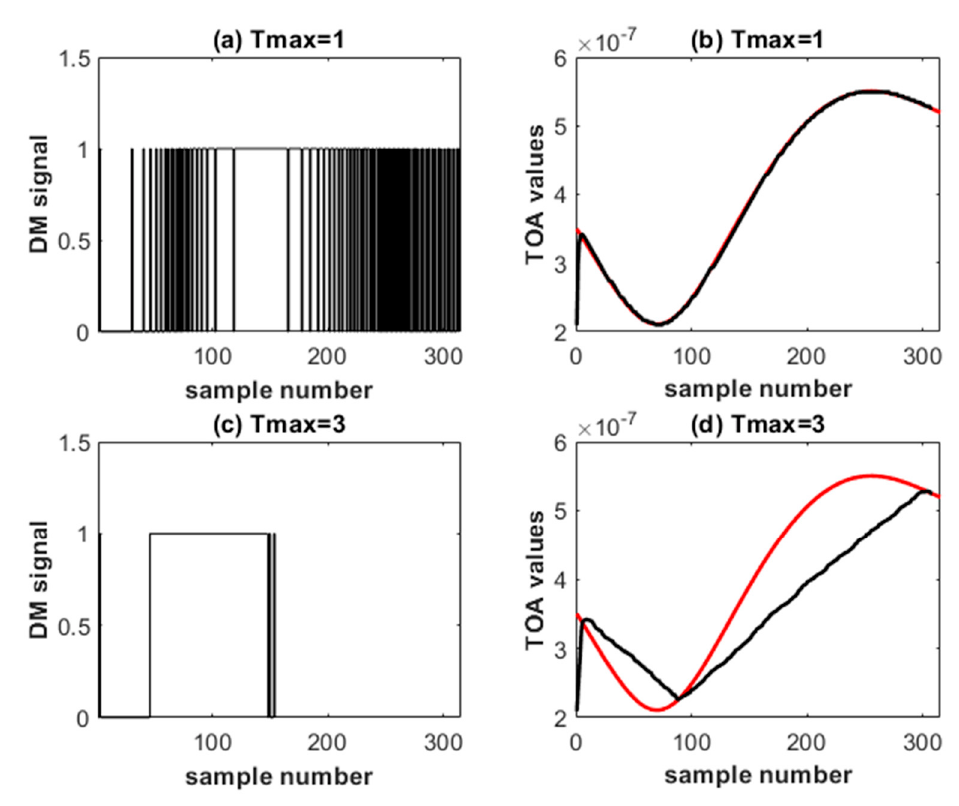
Figure 8. DM signals with original and reconstructed TOA values for the CS-DM localization system. The original TOA values are shown in red, the reconstructed in black. Results are averaged over 100 realizations.